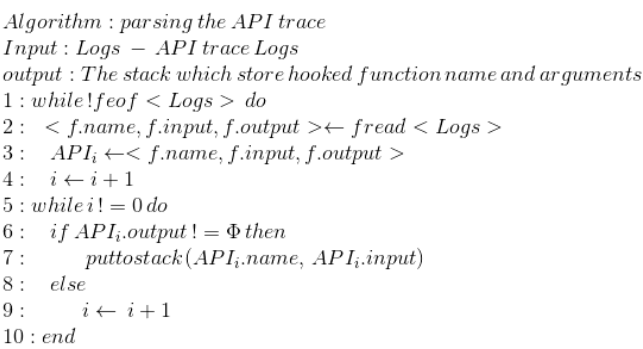
Figure 4. Application programming interface (API) trace parse algorithm (ATPA).